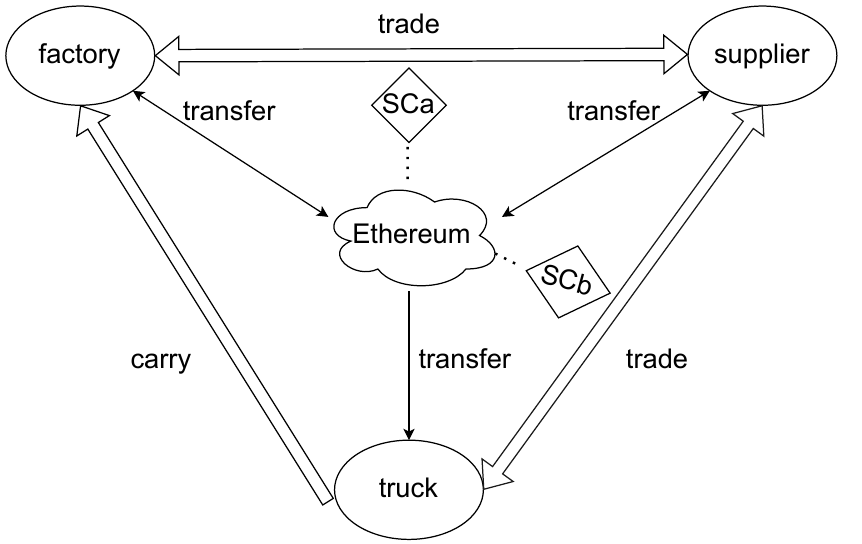
Figure 6. Framework of Ethereum commodity